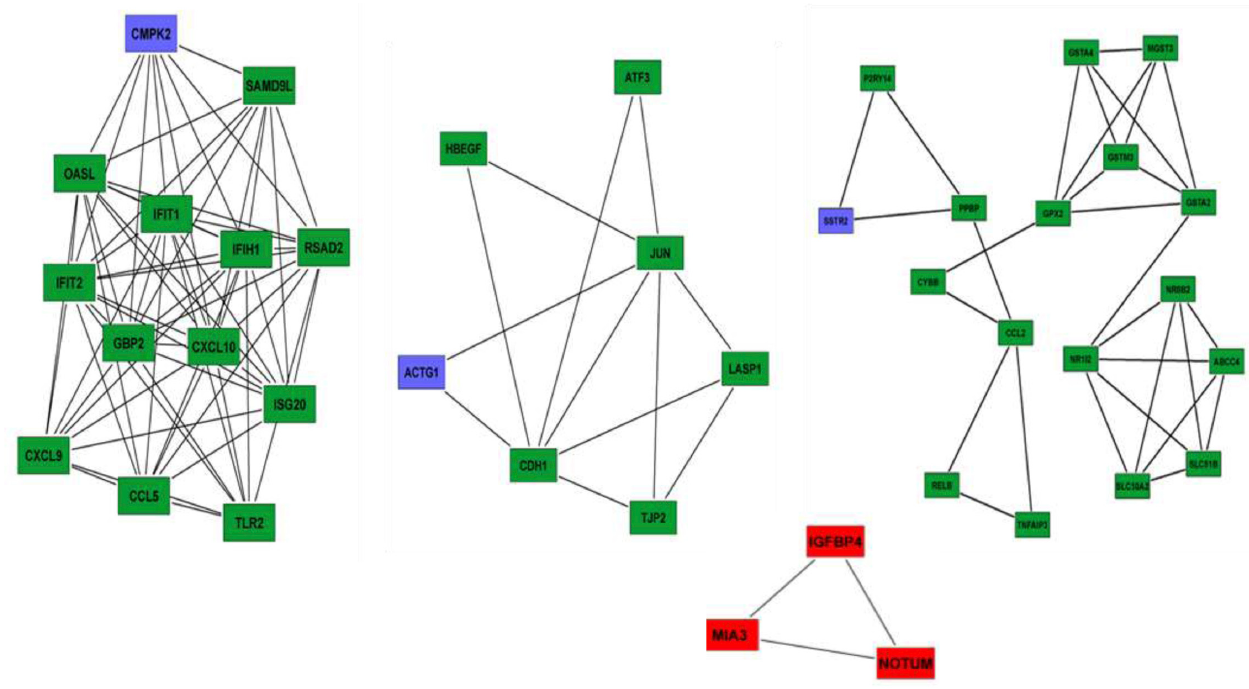
Figure 4. Sub-network analysis was conducted by using the Molecular Complex Detection (MCODE) app from Cytoscape. Top sub-networks on the basis of MCODE score (Degree cut-off= 2, node score cut-off = 0.2, k-core = 2 and max. depth = 100). Upregulated gene group clusters, we identified seed nodes (CMPK2, ACTG1 and SSTR2) in the network (green and blue). In downregulated gene group, we identified only one subnetwork which qualified cut off criteria. Three genes in this sub-network was identified: MIA3, IGFBP4 and NOTUM (red).